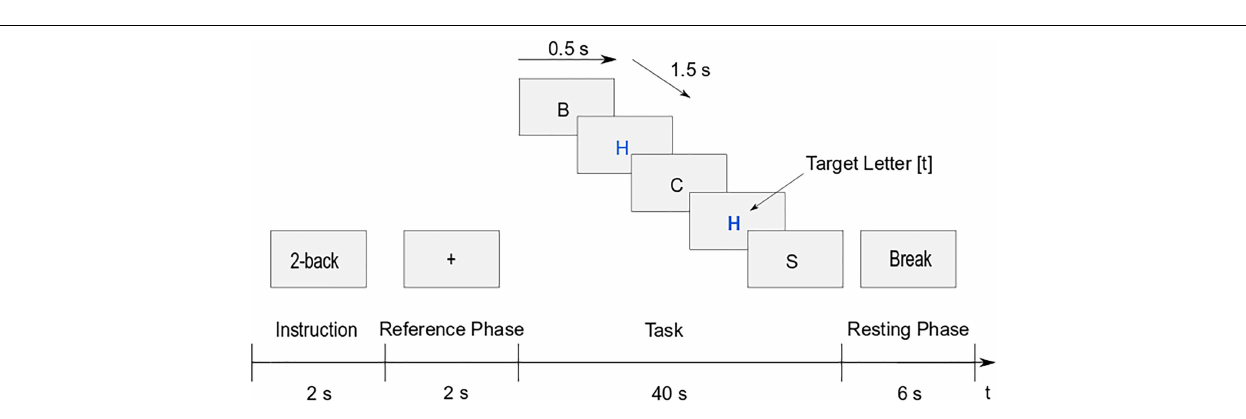
end of the experiment, after the eye artifact correction